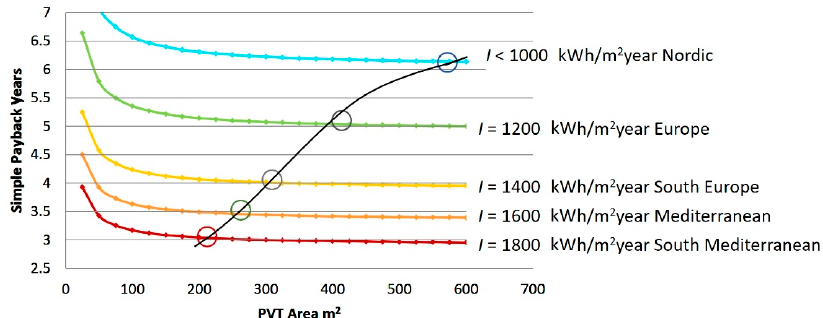
Figure 7. Solar PVT Feasibility Diagram for Europe with Different PVT Plant Size.